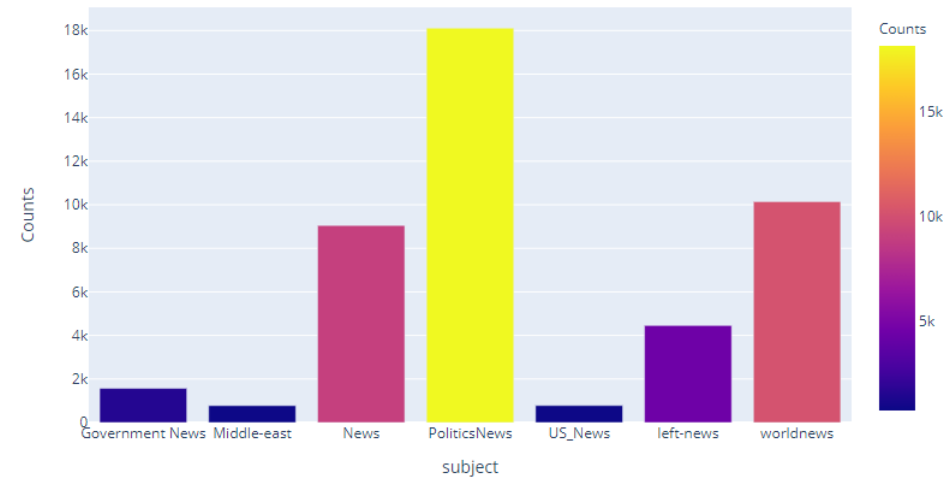
Figure 7. Subject-wise counts of fake and real news.